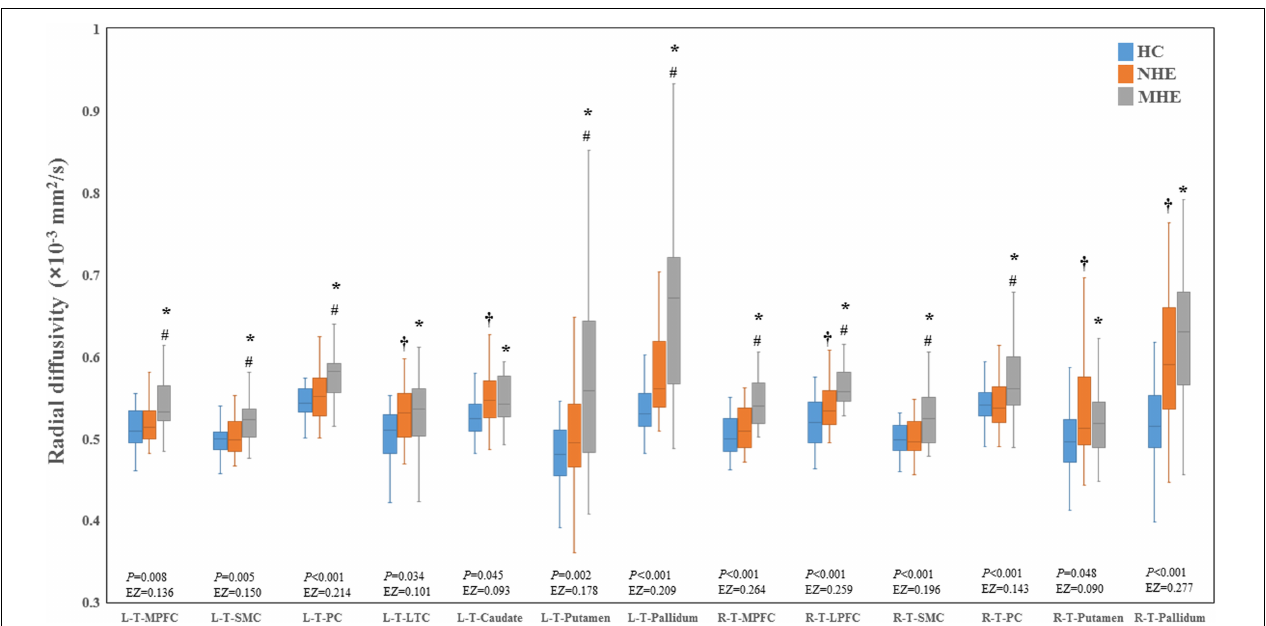
FIGURE 6 | Between-group differences in radial diffusivity. The false discovery rate (FDR)-corrected P values and the effect size (EZ) are shown. The symbols *, † , and # indicate significant differences in MHE vs. HC, NHE vs. HC, and MHE vs. NHE, respectively. MHE, minimal hepatic encephalopathy; NHE, patients without MHE; HC, healthy control; LPFC, lateral prefrontal cortex; LTC, lateral temporal cortex; MPFC, medial prefrontal cortex; PC, parietal cortex; SMC, sensorimotor cortex; T, thalamus; L, left; R, right.